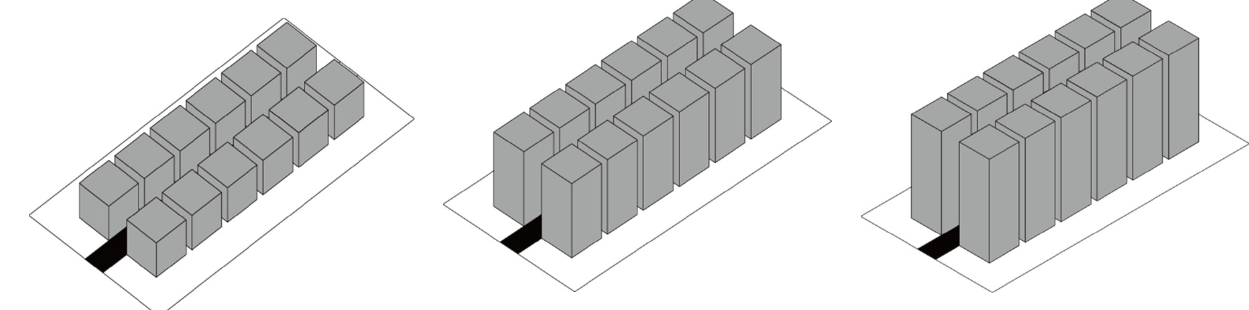
Figure 2. Case study floor area ratio setting.